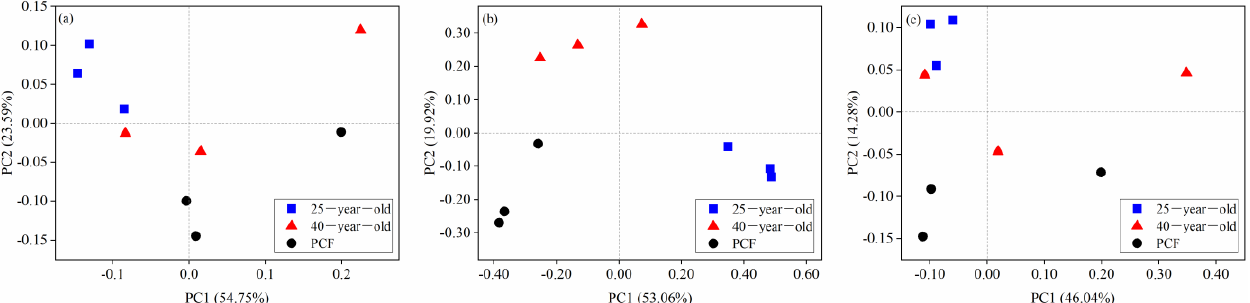
Figure 2. Principal coordinate analysis (PCoA) of the taxonomic patterns of bacterial ( a ), fungal ( b ) and archaeal ( c ) communities across the three stands at the species level. The 25-year-old, 40-year-old and PCF represent the 25-year-old P. rubescens plantation, 40-year-old P. rubescens plantation, and primeval coniferous forest, respectively. Table 2. Taxonomic α-diversity of the microbial community in the three stands at the species level. Table 3. Structural differences of microbial community among the three stands at the species level.